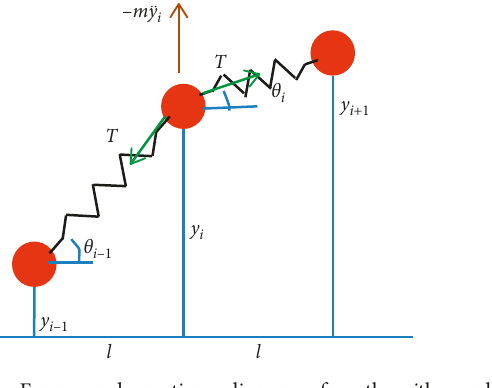
Figure 2: Force and motion diagram for the i th node ( 1 < i < n, ≠ n , n ) d e